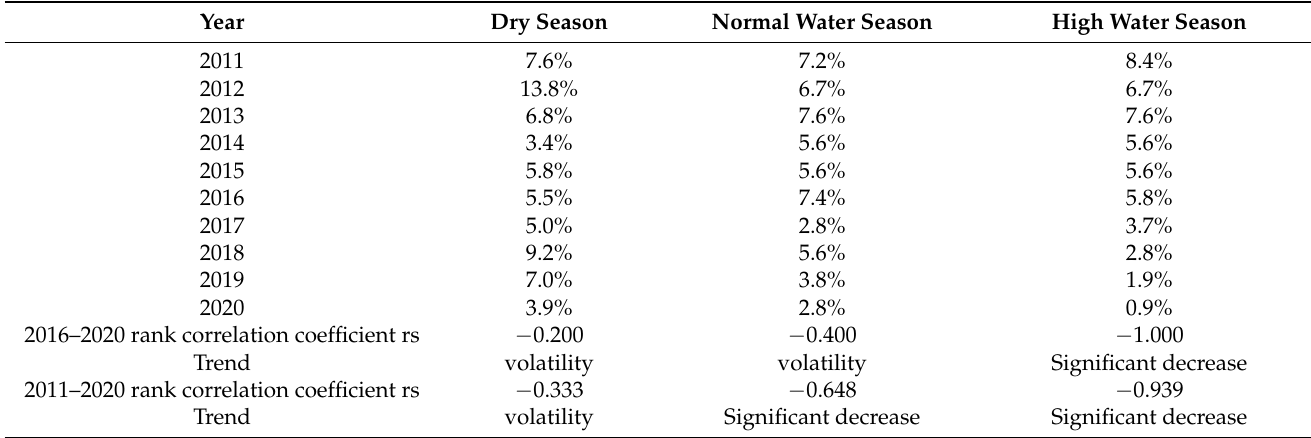
Table 2. The proportion and trend of water quality of inferior Class V in each water stage of Heilongjiang Province from 2011 to 2020.